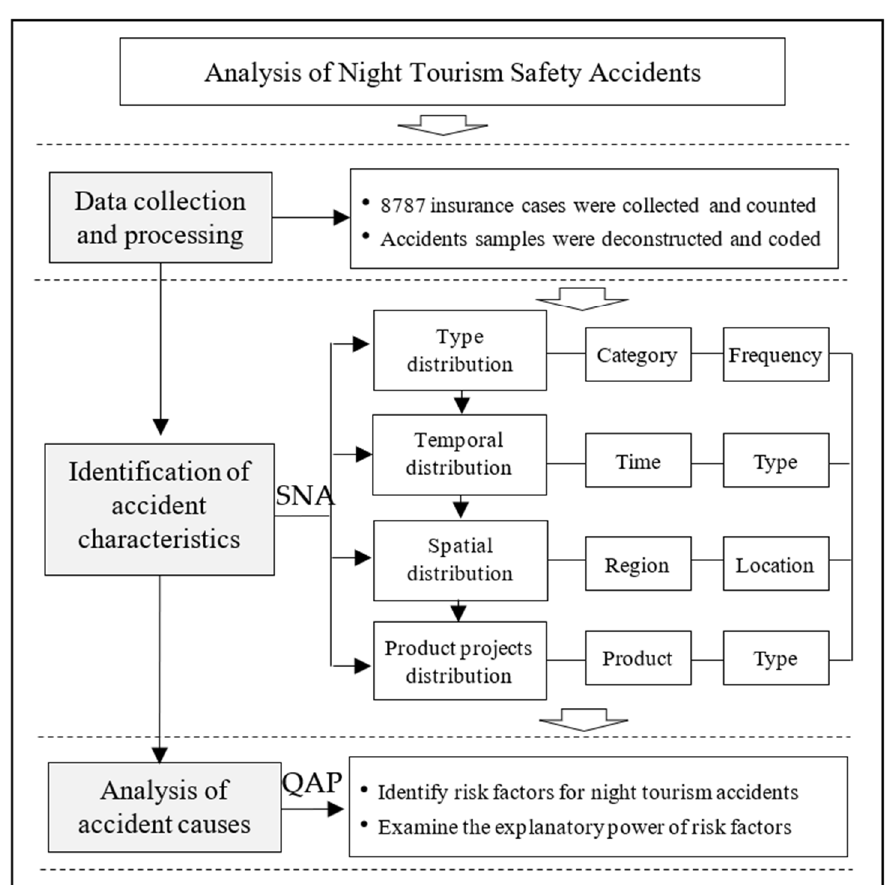
Figure 1. The analytical framework.